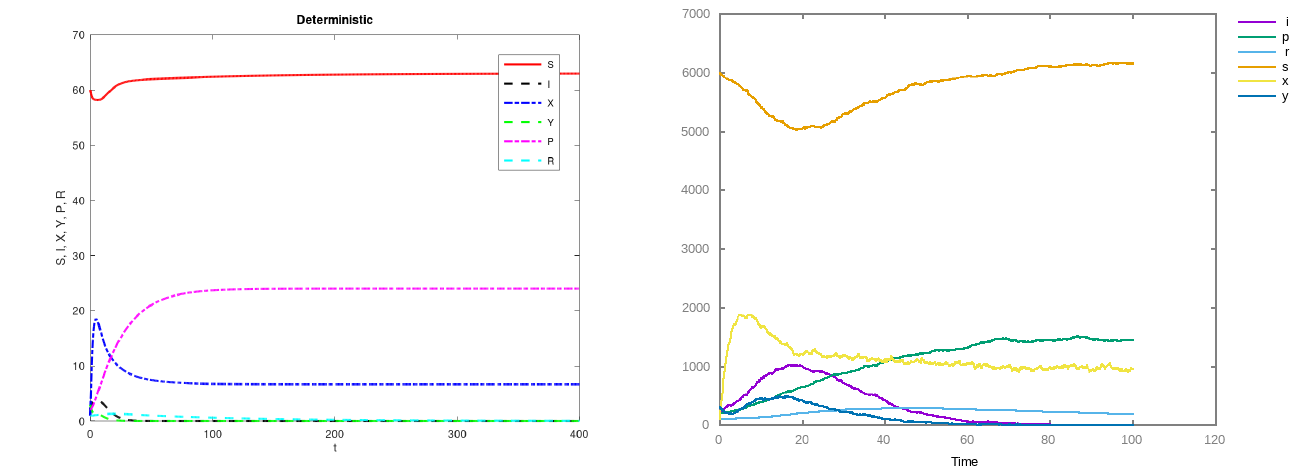
Figure 3. Plots for the virus plant model with mass action interactions and no delays. ( Left ) deterministic. ( Right ) SSA with only the average values